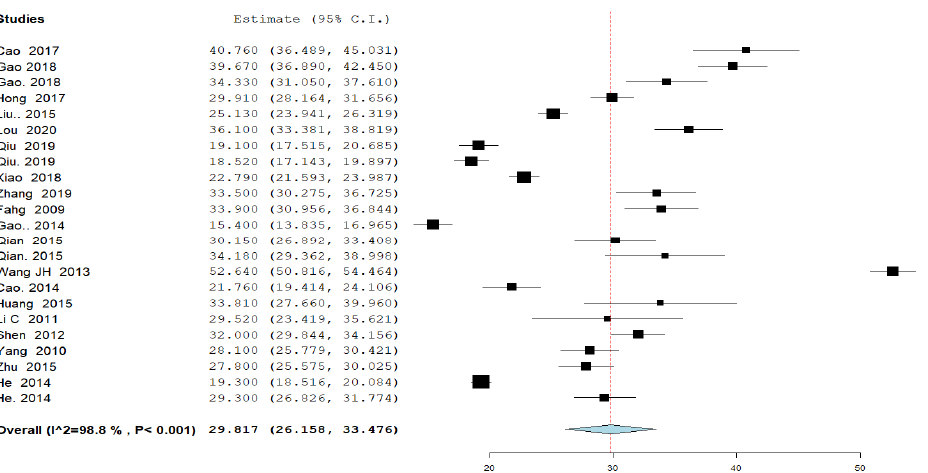
Figure 1. A forest plot of the time for serum β -human chorionic gonadotropin ( β -hCG) normalization (defined as reaching a level of less than or equal to 5 mIU/mL,) in days.